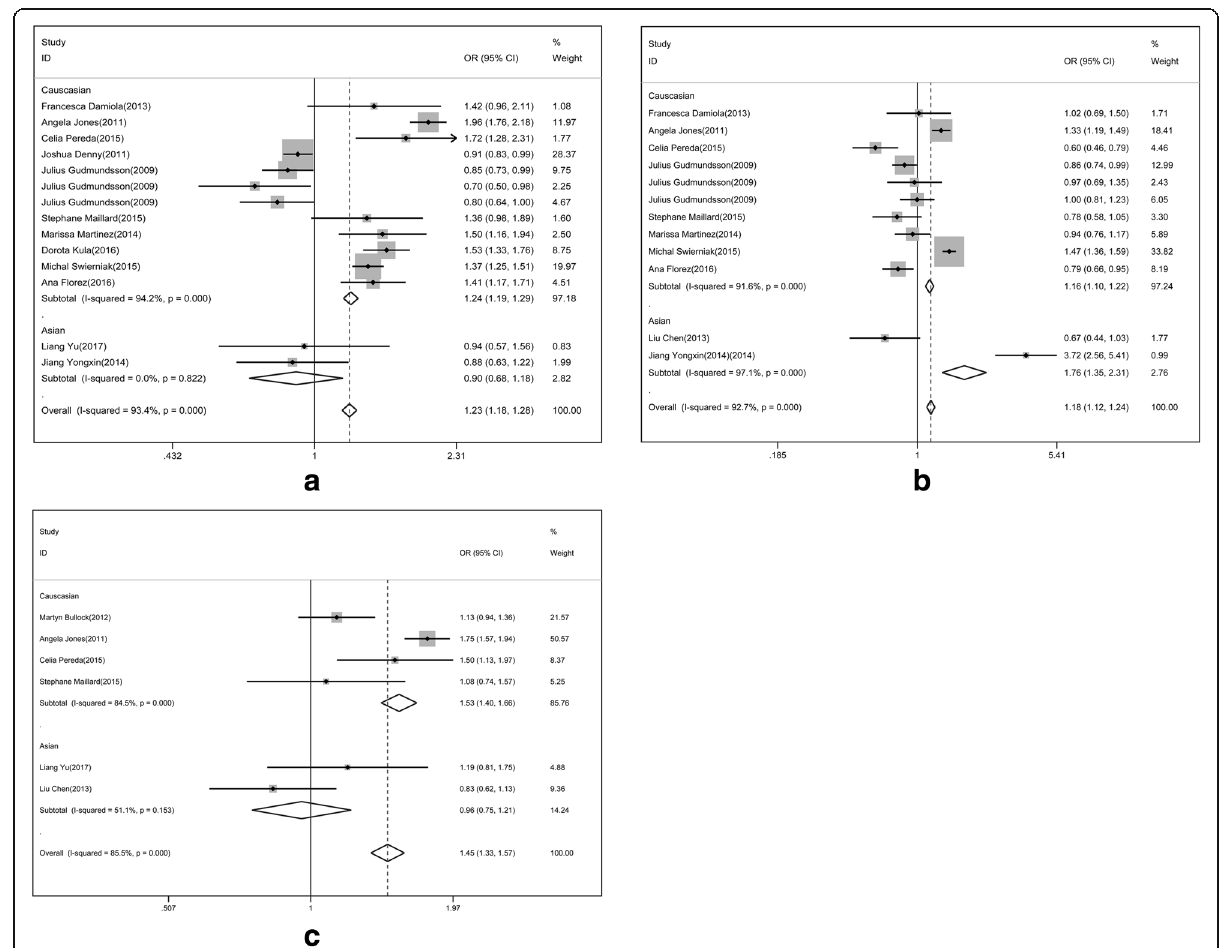
Fig. 5 Sensitivity analysis of 3 SNPs: a . sensitivity analysis in rs965513, b . sensitivity analysis in rs944289, c . sensitivity analysis in